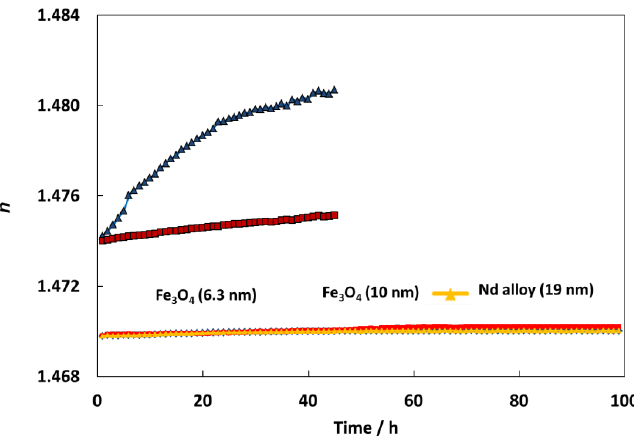
Figure 7. Temporal evolution of the refractive index, n , for TMPTO + 0.015 wt% (Fe 3 O 4 (6.3 nm), Fe 3 O 4 (10 nm) or Nd alloy (19 nm), TMPTO + 0.05% (graphene oxide, GO or reduced graphene oxide,